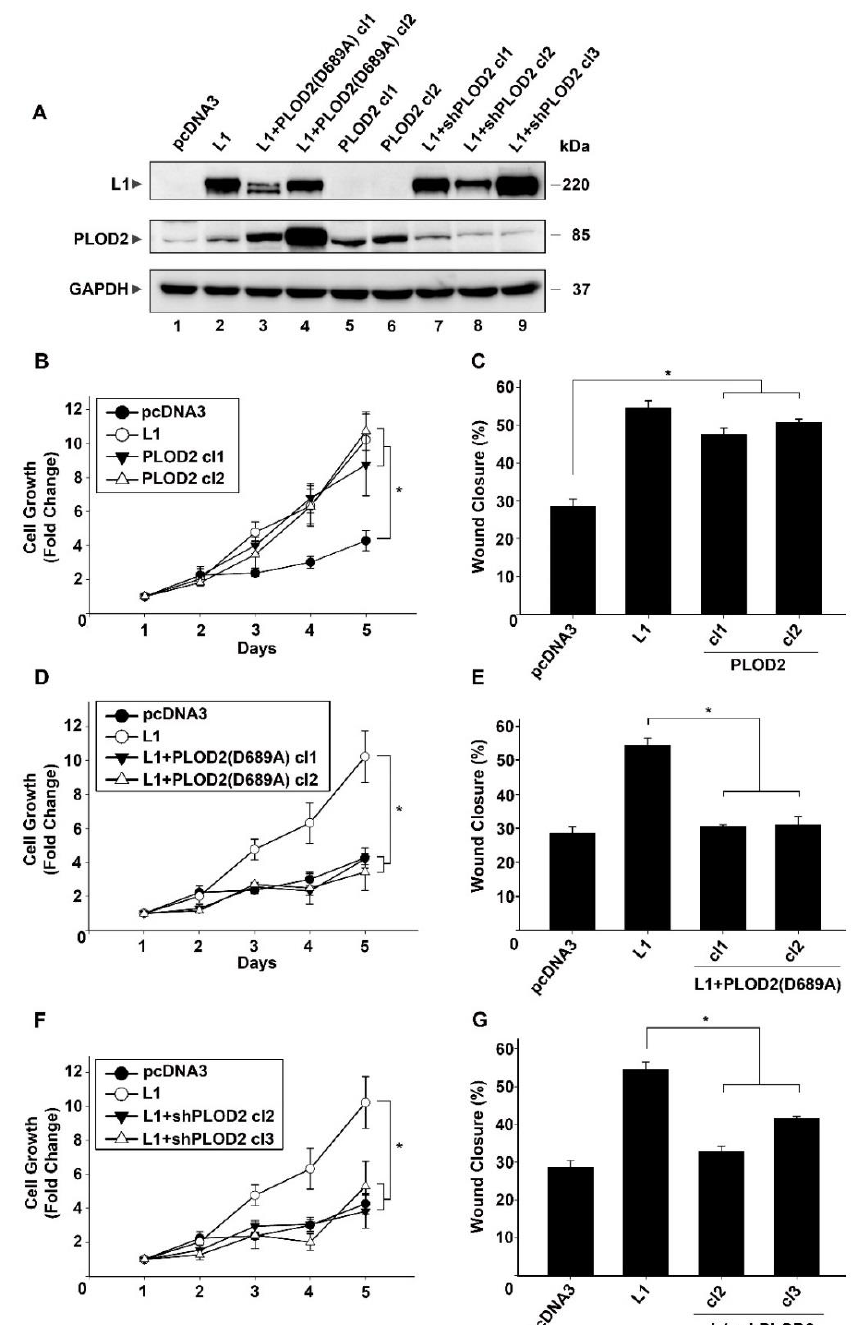
Figure 2. PLOD2 is required for the increase in cell proliferation and motility conferred by L1 in CRC cells. ( A ) The levels of endogenous and transfected PLOD2 proteins were determined in LS 174T cells stably expressing the control pcDNA3 plasmid (lane 1), L1 (lane 2), L1 plus a dominant negative PLOD2 mutant [L1 + PLOD2 (D689A) cl1 and cl2, lanes 3 and 4], PLOD2 (lanes 5 and 6) and L1 plus shRNA to PLOD2 (L1 + shPLOD2 cl1-cl3, lanes 7–9). ( B , D , F ) Analysis of the proliferation rates in serum-free medium of the cell clones described in (A) over 5 days. ( C , E , G ) Analysis of the motility of the cell clones described in (A) by the closure of “scratch wounds” introduced in the confluent monolayers of these CRC cell clones. * p < 0.05.